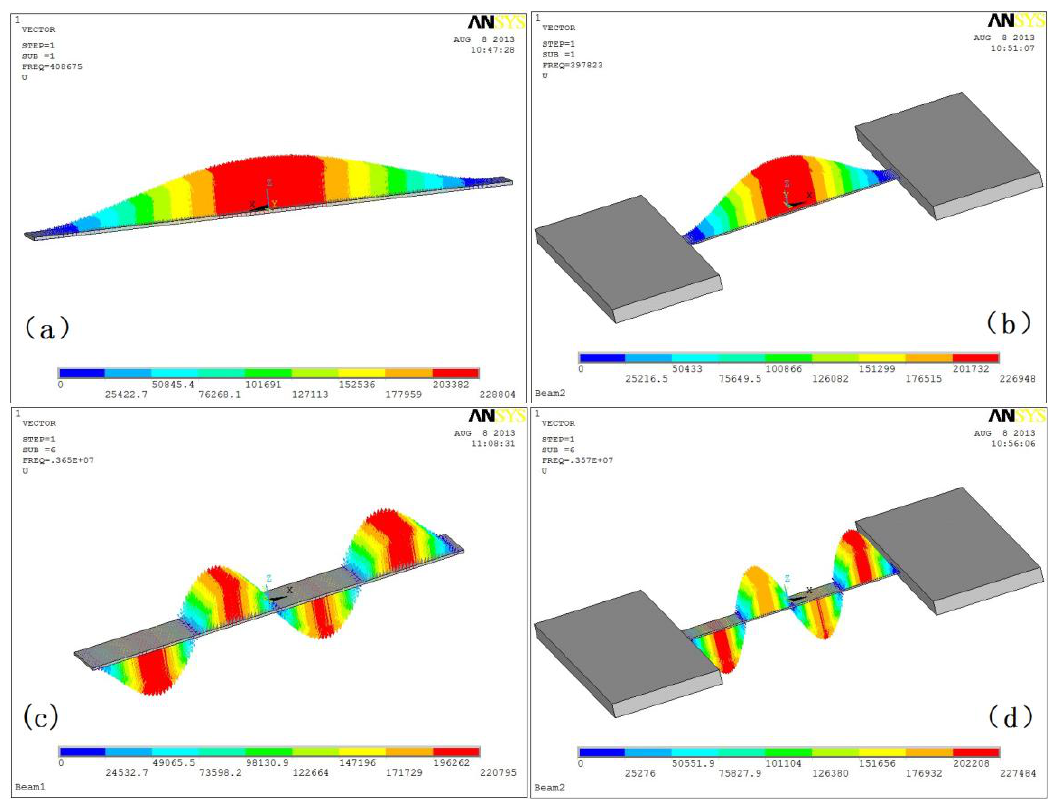
Figure 5. Modal vectors of the first and fourth mode shapes solved by FEM. ( a ) and ( b ): First modal under rigid and flexible boundary, respectively; ( c ) and ( d ): Fourth modal under rigid and flexible boundary, respectively.